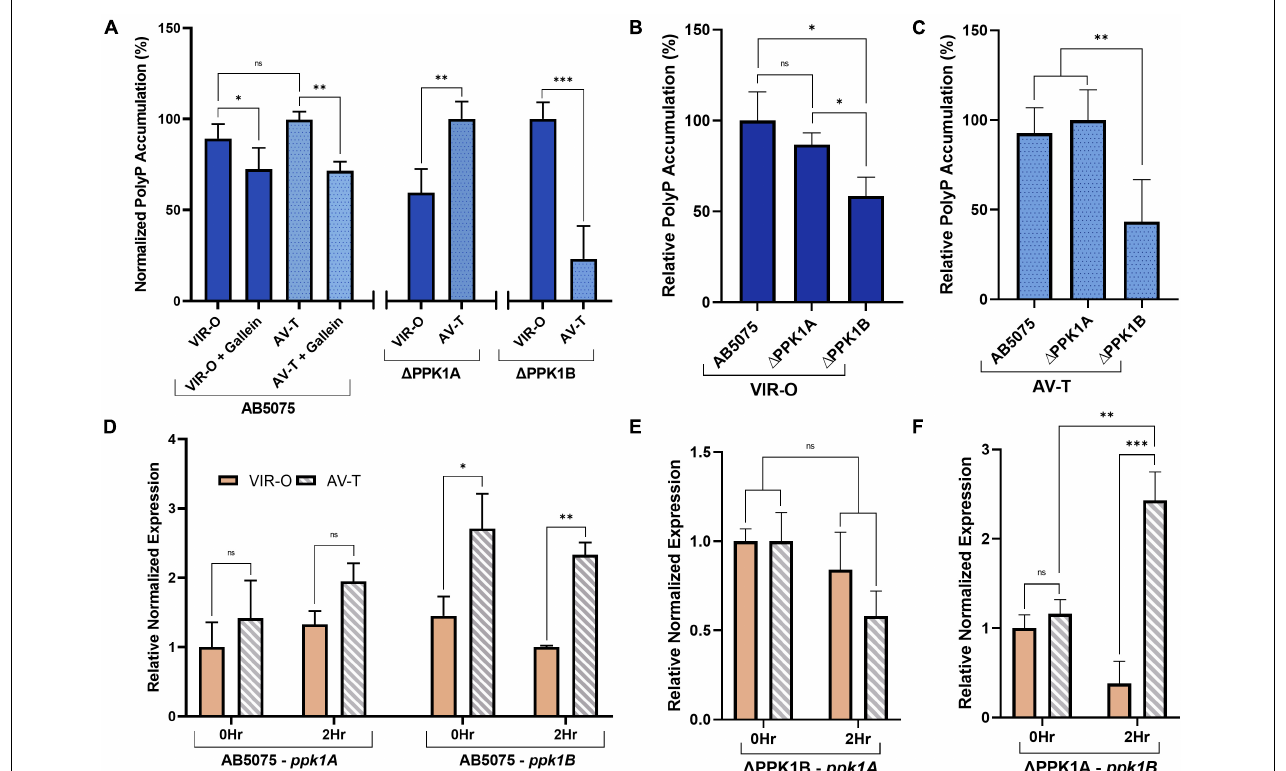
FIGURE 3 | A. baumannii polyP accumulation and PPK1 transcription display phase-variant specific regulation. (A) Relative phase-variant specific starvation-induced polyP accumulation of all strains. Parent and individual PPK1 knockout strains polyP levels are normalized with respect to the higher signal phase-variant. (B,C) Starvation-induced polyP accumulation of VIR-O (B) and AV-T (C) phase-variants between parent and PPK1 knockout strains. Data points are the average from triplicates or more; error bars are ± SD. (D) Phase-variant specific relative normalized expression of ppk1A and ppk1B in A. baumannii parent